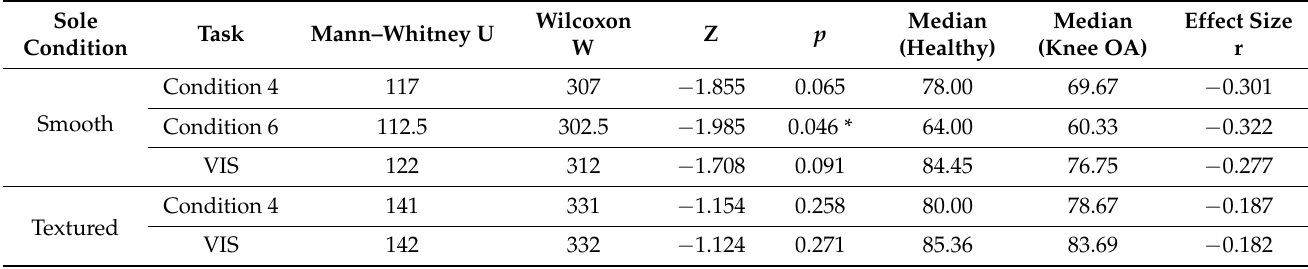
Table A3. Mann–Whitney U tests results. (Null hypothesis: both knee OA and healthy knee group will have the same scores from balance tests.) Sole Task Condition